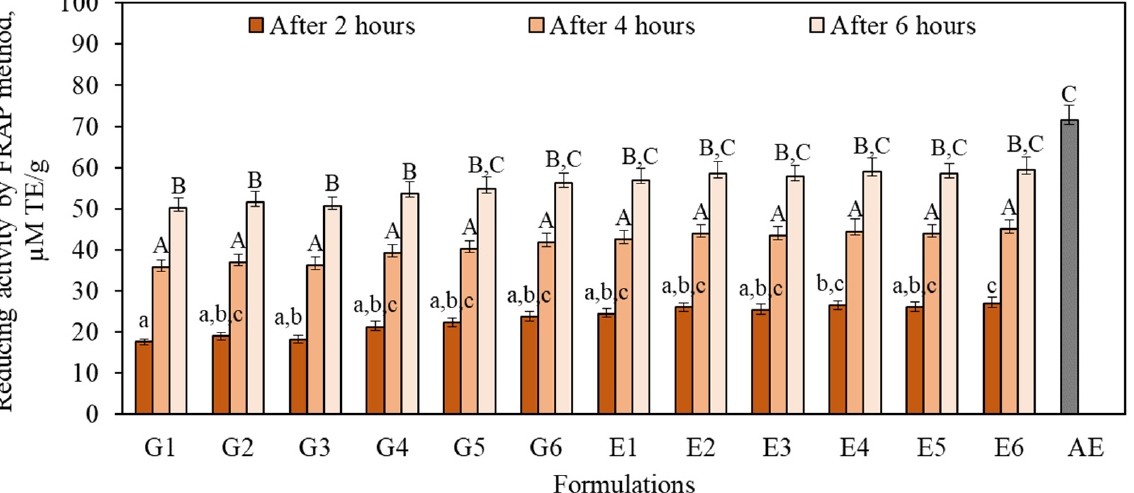
Figure 7. Reducing activity evaluated in gel (G1–G6) and emulgel (E1–E6) formulations and in 1% AE by the FRAP method. The means followed by different uppercase and lowercase letters are significantly different at p < 0.05.